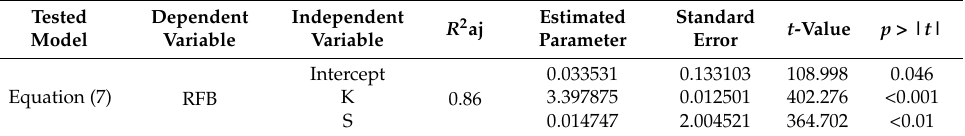
Table 7. Estimated parameters, standard errors of the fitted models.